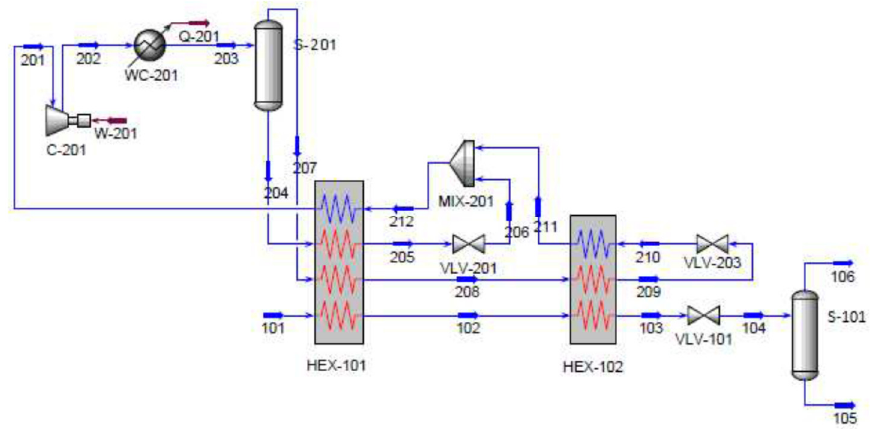
Figure 49. Cascade PLNG process [191].